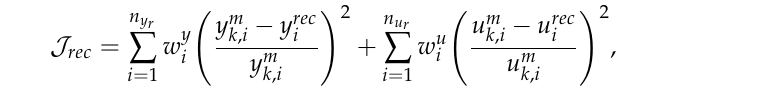
Table 1. Measured output variables. Variable Description Weight ( w y ) Volumetric fraction of nC 5 and iC 5 in LPG 10 3 Top temperature of tower T-03 10 4 Bottom temperature of tower T-03 10 5 Condenser temperature of tower T-03 10 5 Fraction C 3/ ( nC 4 + iC 4 ) in LPG 10 4 Temperature of the control tray of tower T-03 10